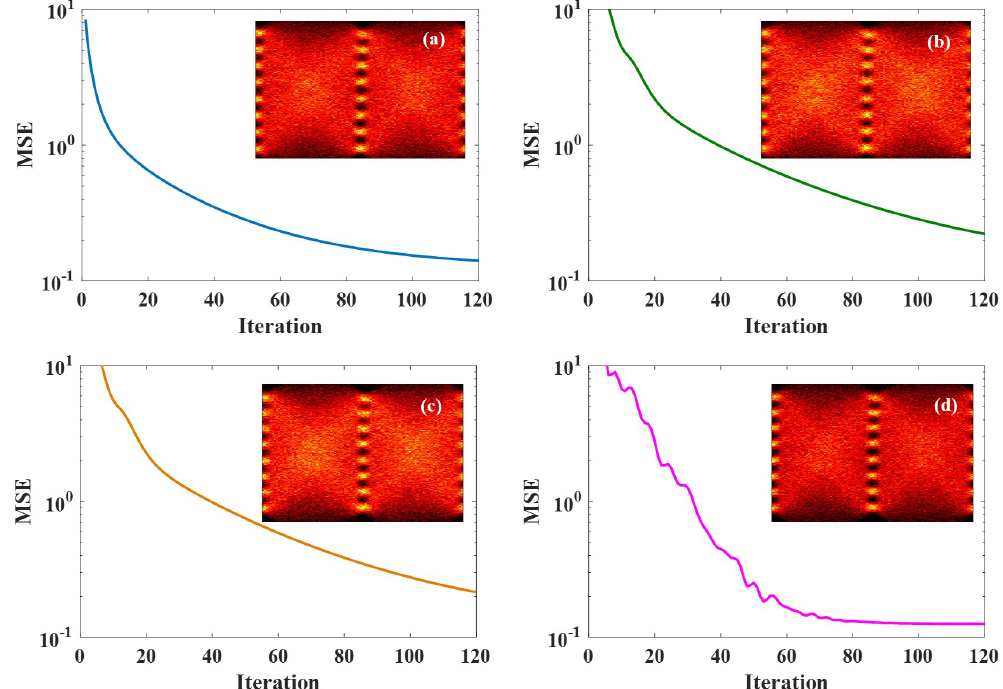
Figure 3. MSE curves of different optimization algorithms applied to 129-Gbit/s optical PAM8 system at ROP of − 1 dBm after 2-km SSMF transmission. ( a ) BGD method; ( b ) AdaGrad algorithm; ( c ) RMSProp algorithm; and ( d ) Adam algorithm. Insets are eye diagrams of the equalized signals using the corresponding optimization